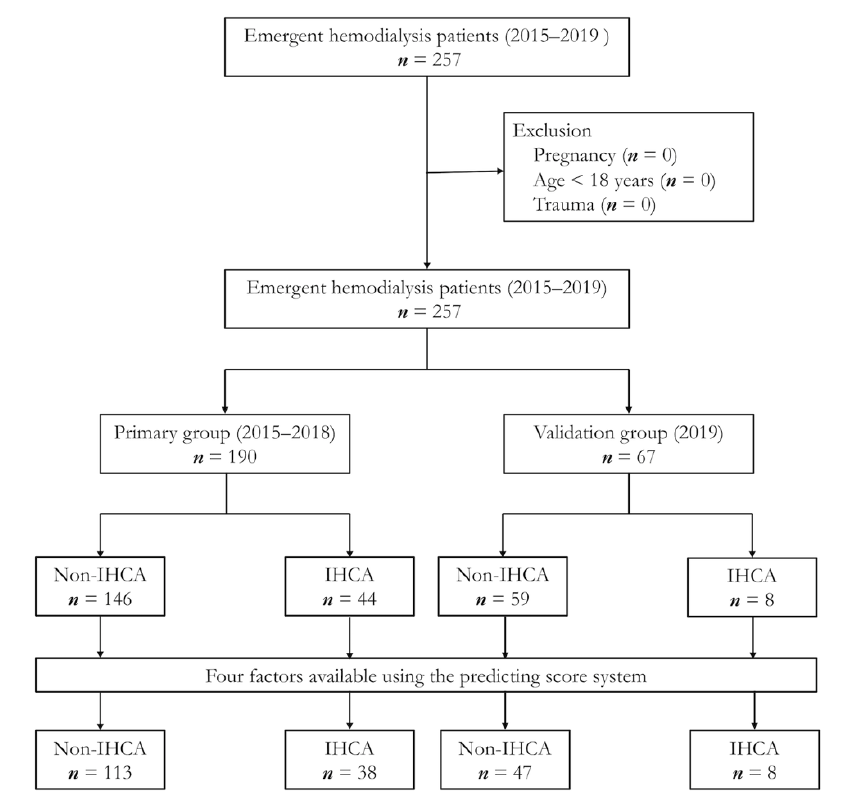
Figure 1. The patient flow diagram. IHCA: in-hospital cardiac arrest.